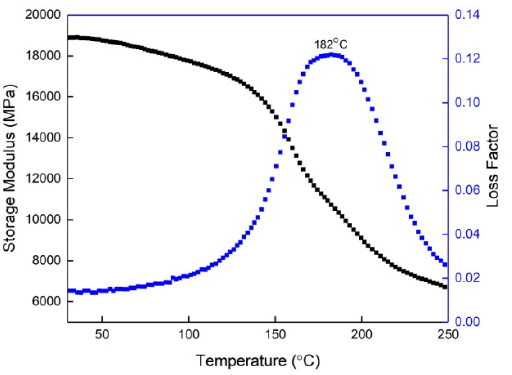
Figure 12. DMA curves for rosin-sourced epoxy prepreg laminates with 57% CF volume fraction, manufactured by autoclave.